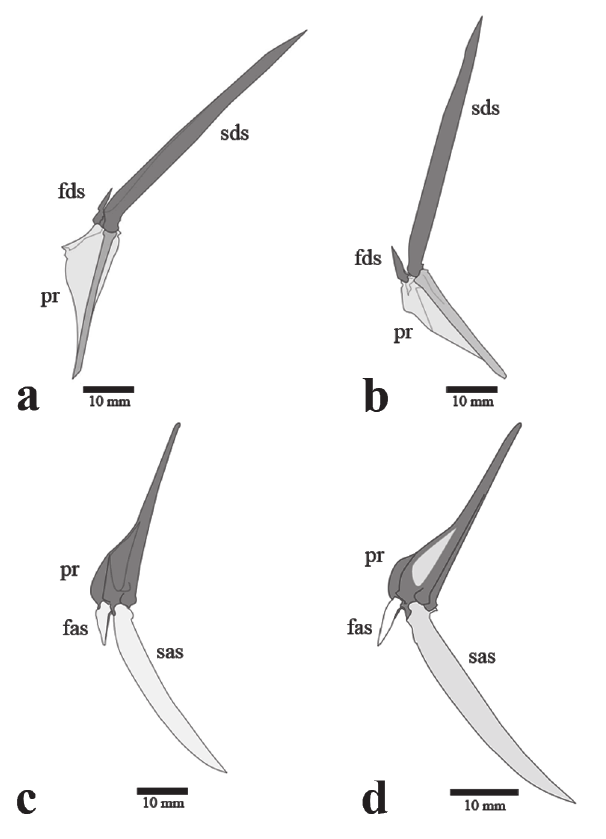
Fig. 6. Premaxillary bone, dorsal view, in ( a ) Eugerres castroaguirrei ECOSC 5511-1, and ( b ) E. mexicanus UABC 2666. ap = ascending process, arp = articular process, cp = caudal process, sp = symphysial process. Pharyngeal plates in ( c ) E. castroaguirrei and ( d ) E. mexicanus : dorsal view (d.v.) and lateral view (l.v.). pt = pharyngeal dentition.